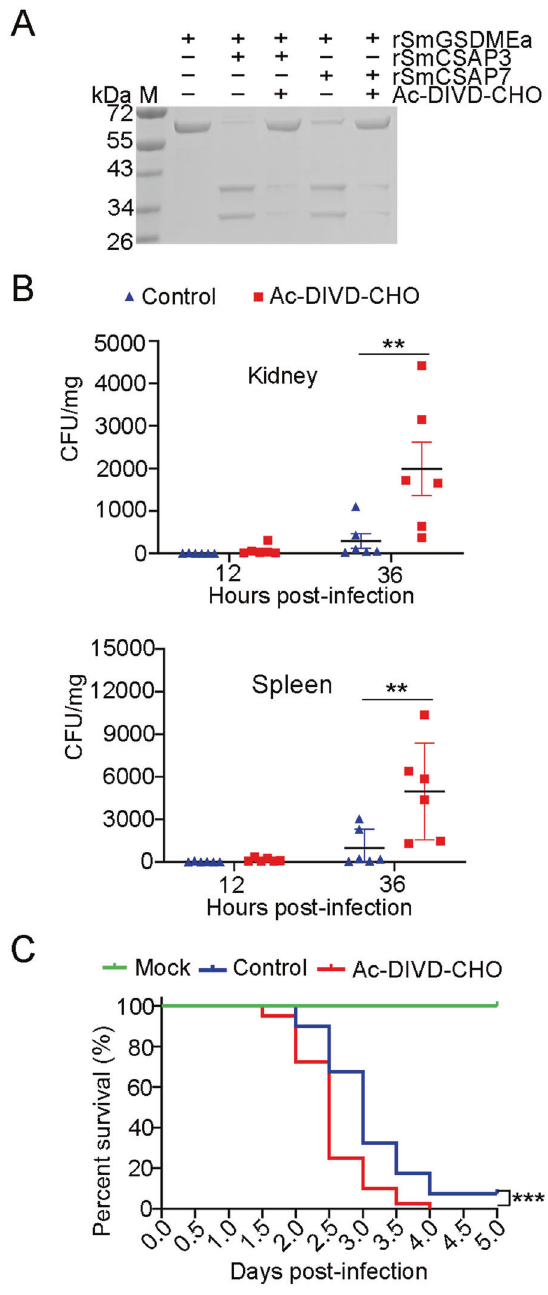
Fig. 8 Interfering with the activity of SmCASP3/7 in turbot promotes Vibrio harveyi infection. A rSmGSDMEa was treated with rSmCASP3/7 in the presence or absence of Ac-DIVD-CHO. The samples were then analyzed by SDS-PAGE. B Turbot were infected with V. harveyi in the presence or absence (control) of Ac-DIVD-CHO for different hours, and bacterial loads (shown as Colony Forming Unit, CFU) in kidney and spleen were determined. Values are shown as means ± SD, n = 6. ** P < 0.01. C Turbot in two groups were infected with V. harveyi in the presence or absence (control) of Ac- DIVD-CHO. The mock infection group was treated with PBS. The fi sh were monitored daily for mortality. The signi fi cance between the survivals of Ac-DIVD-CHO-treated fi sh and control fi sh was determined with logrank test. n = 40 *** P <